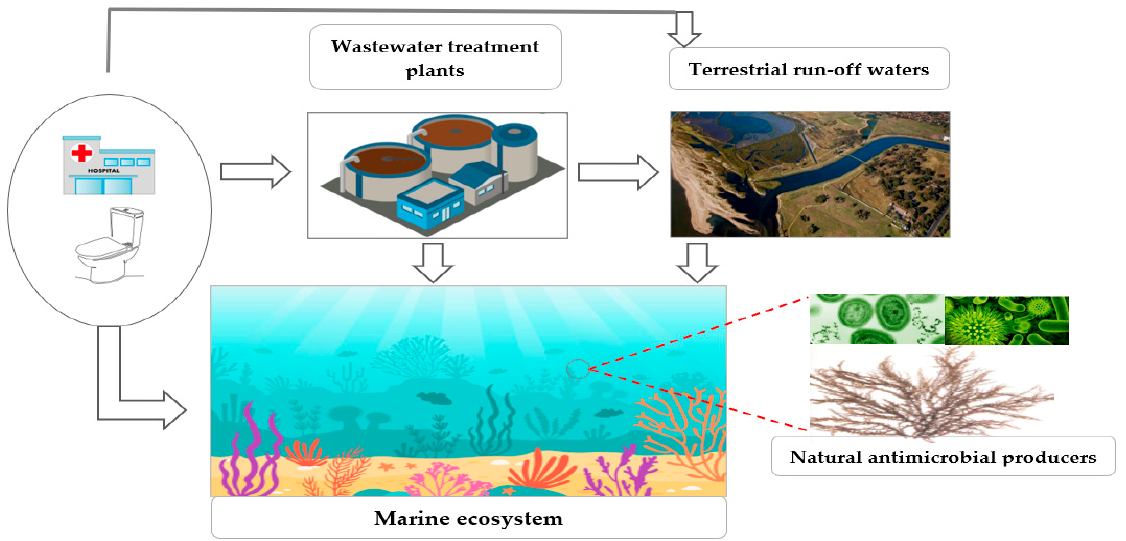
Figure 1. Graphical diagram of the spread of CRB (carbapenem-resistant bacteria) or CRGs (carbapenem-resistant genes) into the marine environment. The diversity of CRB or CRGs in the seawater can be sourced from the human communities and loaded into the marine matrices either via direct sewage disposals or via the outfall of wastewater treatment plants. The marine coastal environment may also receive CR (carbapenem resistance) from polluted rivers and other terrestrial run-off waters. The occurrence of CR in the ocean can be due to the selection pressure of natural β -lactam antibiotics produced by other marine microorganisms.